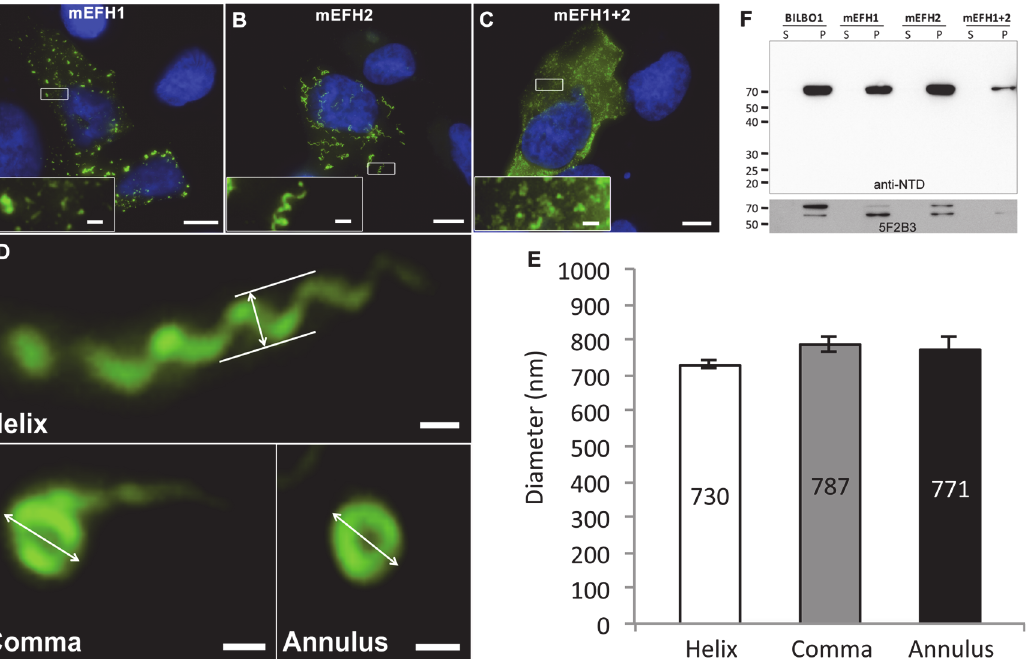
Fig 5. The EF-hand domains modulate the morphology of polymers formed by BILBO1. (A-D) Immunofluorescence panels. EH-Hand motif 1, EF-hand motif 2 and both motifs were mutated by site-directed mutagenesis (see Fig. 1). The resulting mutant proteins mEFH1 (A), mEFH2 (B), and mEFH1+2 (C) were expressed for six hours in U-2 OS cells, and the resulting polymers were immuno-localized using the anti-NTD antibody. The inserts in the bottom left of panels represent higher magnifications of structures observed in these panels. Scale bars represent 10 μ m, and scale bars in magnified insets represent 1 μ m. (D) Enlarged views of the helix, comma and annulus shaped polymers formed by mEFH2 in U-2 OS cells 24 hours post-transfection. Scale bar represents 500 nm. (E) Helix, comma and annulus shaped polymers have comparable dimensions as shown by the measurements of their respective diameters. (F). A western blot probed with anti-NTD (upper panel) against protein samples collected from U-2 OS cells after six hours of expression of BILBO1, mEFH1, mEFH2 or mEFH1+2 proteins. Samples were collected from pellets and supernatants of detergent extracted cells. BILBO1, mEFH1, mEFH2 and mEFH1+2 were insoluble and subject to degradation as shown with the anti-BILBO1 5F2B3 monoclonal antibody labelling (lower panel) that recognizes the coiled-coil